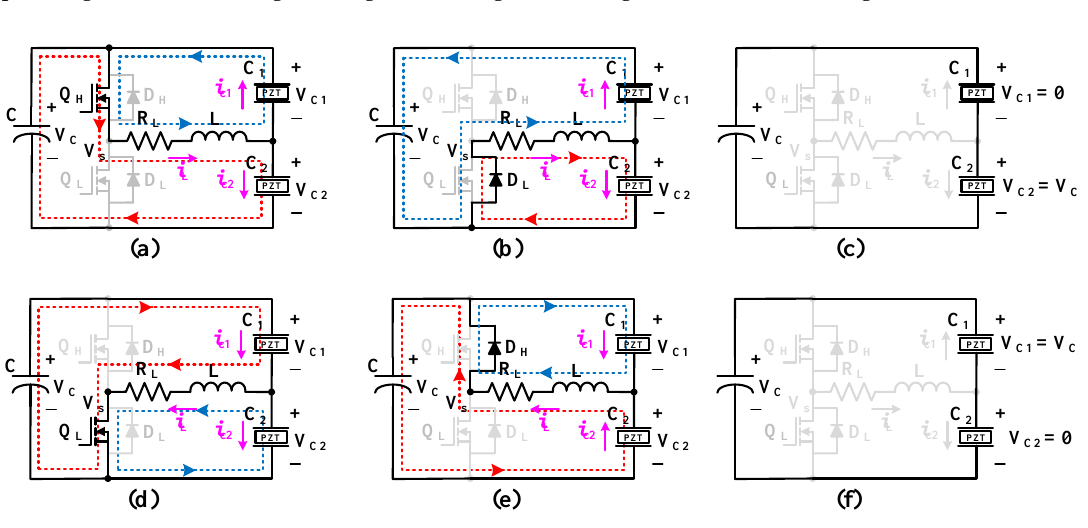
Figure 6. Six switching modes of the high-voltage half-bridge drive stage.